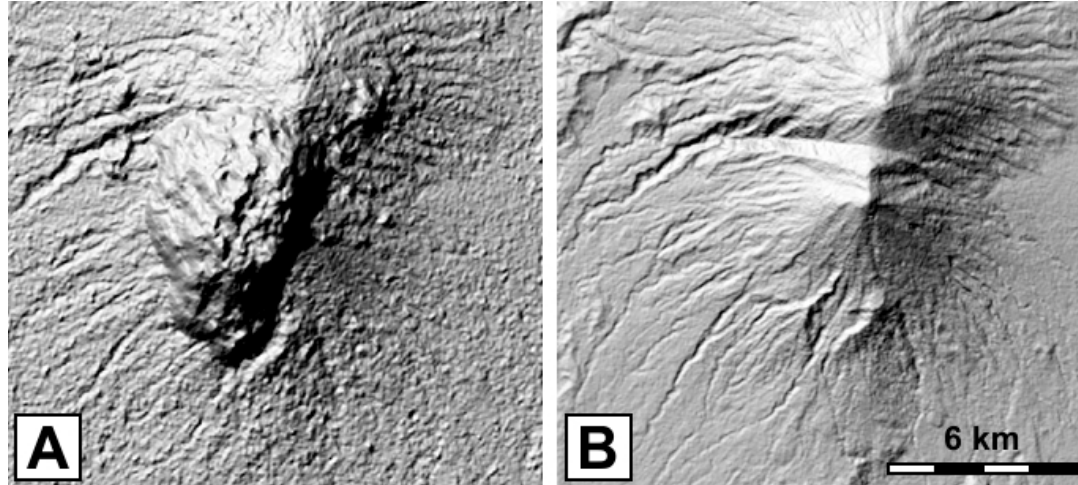
Figure 7. Examples of ASTER-derived DEMs for Fuego Volcano, Guatemala (summit location: 14.48°N, 90.88°W). ( A ) Single-scene DEM from VNIR data acquired on 10 December 2018. Clouds are causing the erroneous topographic high that obscures the summit and central crater. The pixel to pixel noise is also clearly visible. ( B ) ASTER GDEM v3 using only cloud-free scenes and greatly improving the signal to noise of the DEM.